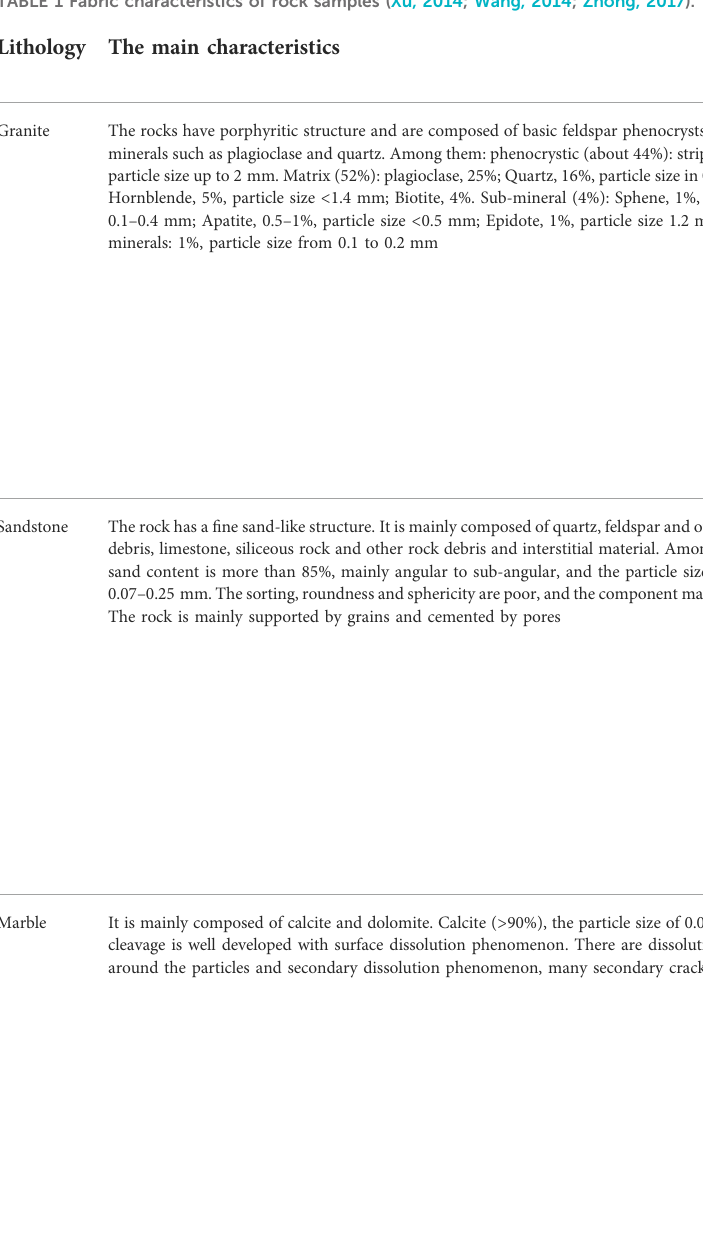
TABLE 1 Fabric characteristics of rock samples (Xu, 2014; Wang, 2014; Zhong,